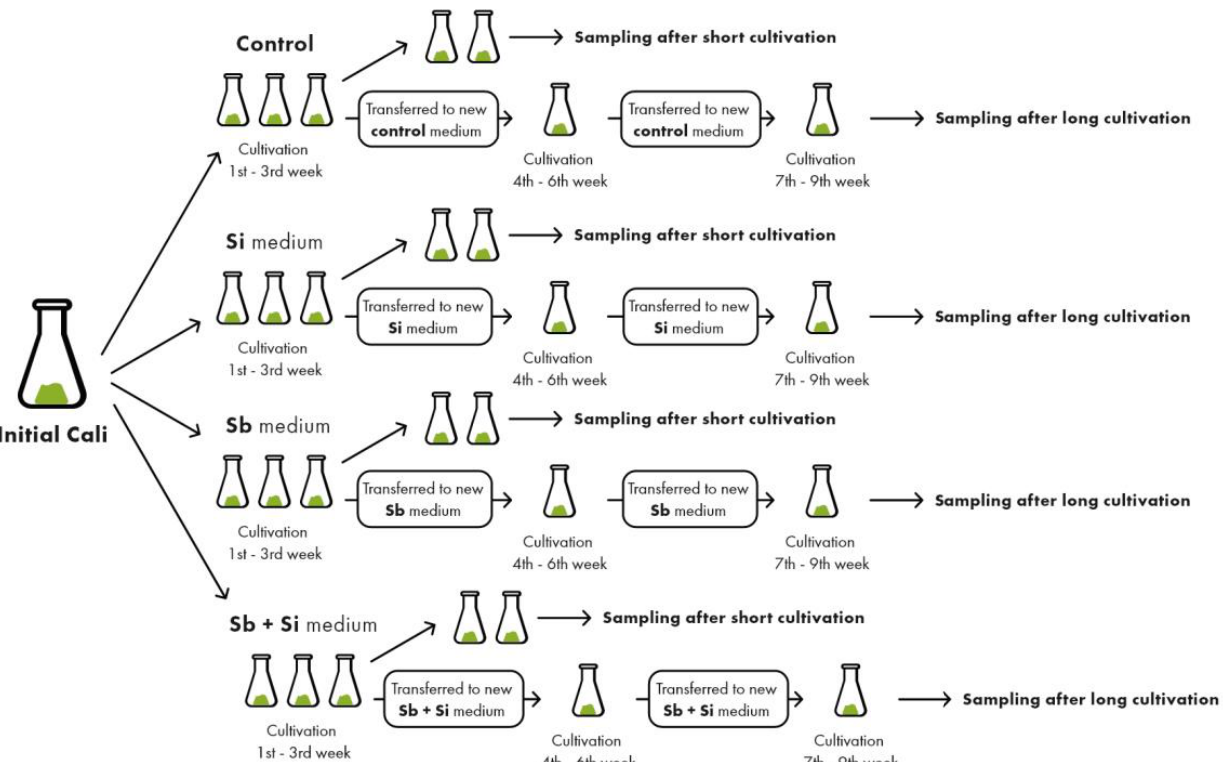
Figure 1. The scheme of experimental design. The initial callus material was first inoculated into the control, Si, Sb, Sb + Si media (15 callus samples for every treatment). The weight of the inoculum at the beginning of each cultivation was 1–1.5 g. For the effects of short cultivation, 10 calli from every treatment were sampled after 3 weeks of the cultivation. The rest of the callus samples (five for every treatment) was transferred into a new media (control treatment to control media, Si treatment to Si media, Sb treatment to Sb media, and Sb + Si treatments to Sb + Si media). At the end of the sixth week of the cultivation, the calli were again transferred into a new control, Si, Sb, Sb + Si media (10 callus samples for every treatment). For the effects of a long cultivation, 10 calli from every treatment were sampled after 9 weeks of the cultivation. Each growth experiment, repeated three times on separate days, consisted of 30 callus samples per treatment.